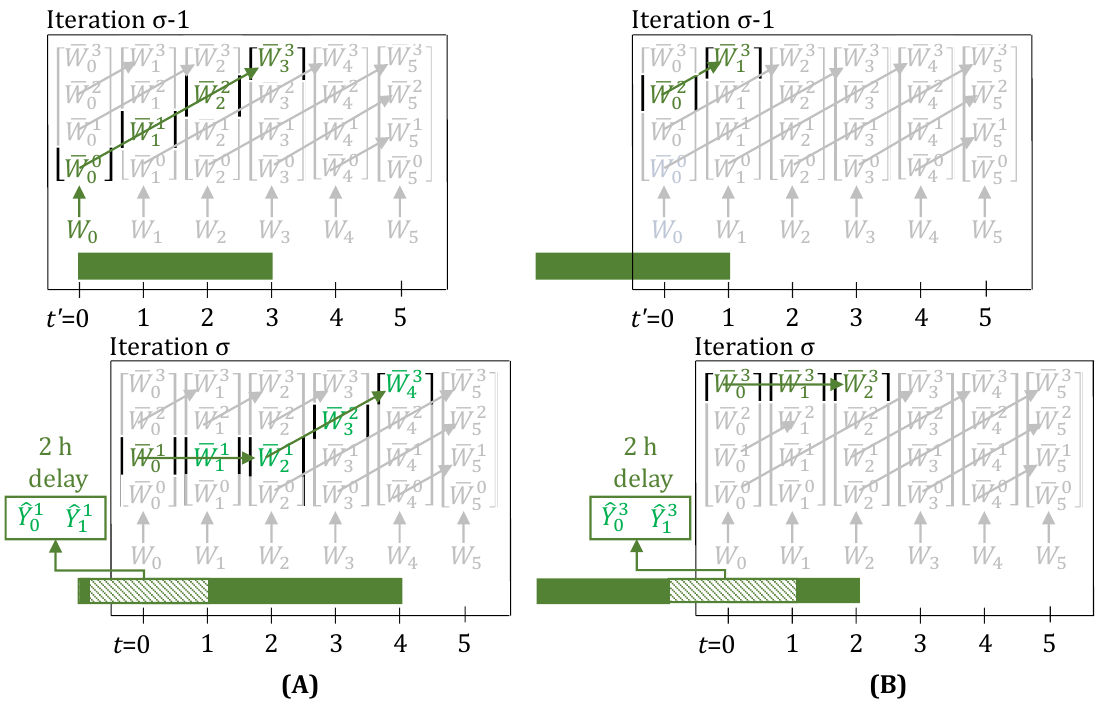
Figure 3. When a 2 h delay is observed, through the lifting equations, ¯ W n trajectory, leading to the task correctly finishing 2 h late in iteration σ . Here, τ for the task is 3. Arrows show which variables are enforced as equal by the lifting equations (Equations (11) and (12), with delays present). Variables and parameters in green have a value of 1, rest have value 0. ( A )